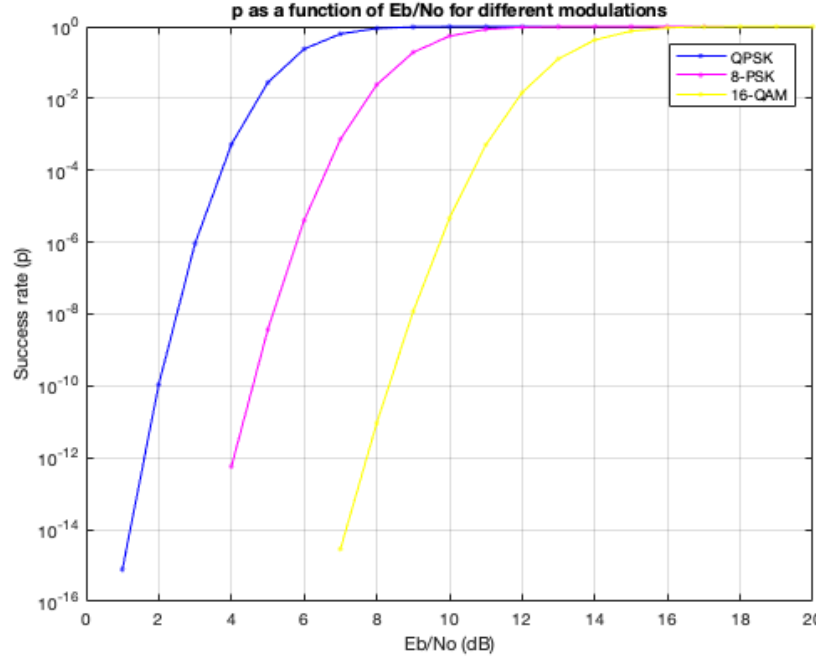
Figure 10. Success rate based on the BER models for different